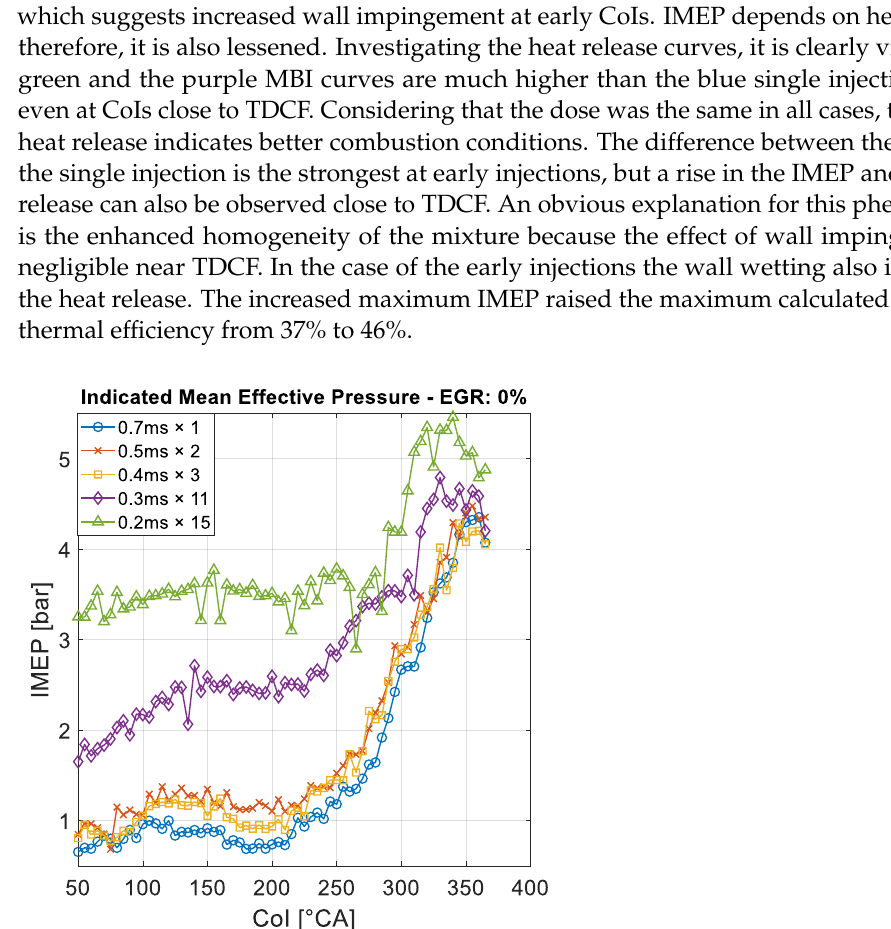
Figure 4. The heat release of the investigated structures with the same dose in the function of CoI without EGR. Improved air–fuel mixing increases the heat release at every injection timing, but wall wetting’s detrimental impacts emerge only at early injections. To determine whether wall impingement is reduced, comparison with the absolute heat release values is unen- lightening. Instead of this, the heat release values compared to the maxima of the heat release curves are investigated. Figure 5 shows the heat release curves divided by the maxima of each curve as a percentage. The specified curves show the extent to which the heat release changed depending on CoI. If a data point is higher at an early CoI, it means that the heat release’s diminution is less in that case. The main reason for lower heat release due to insufficient burning at early injection timings is wall impingement; therefore, higher specific curves mean lesser wall wetting. The differences between the MBI and the single injection are clear. The MBI